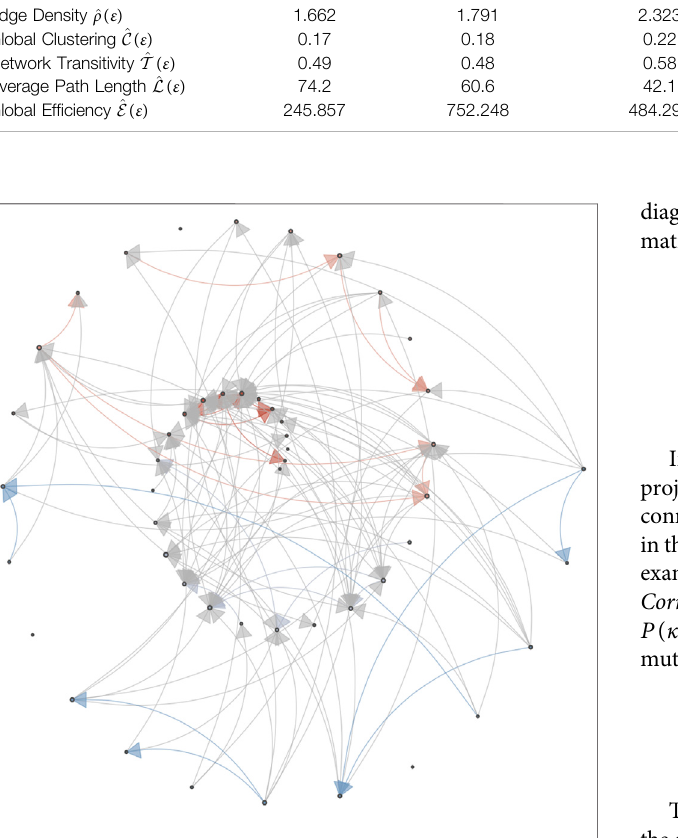
FIGURE 4 | The fi rst 50 vertices of a weighted, directed cumulative Recurrence Network (cRN) based on the lower triangle of the recurrence matrix of the Mood